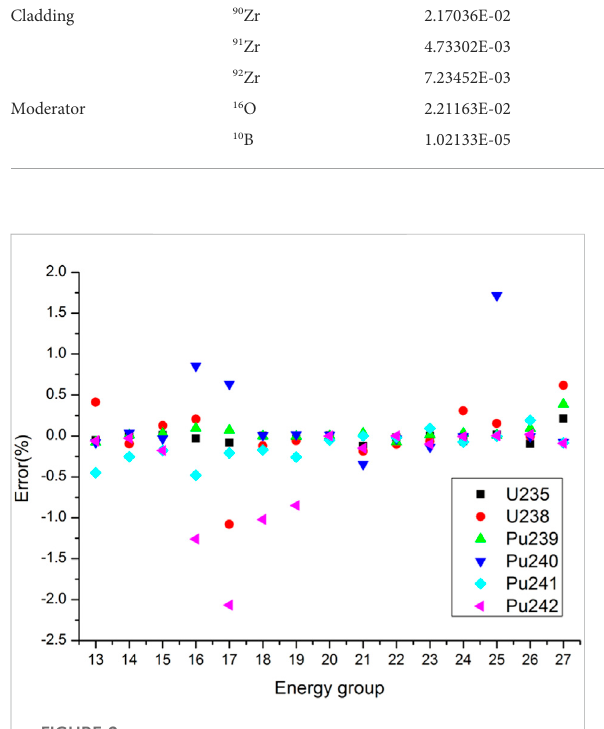
FIGURE 2 Comparison of resonant nuclides ’ total cross sections.